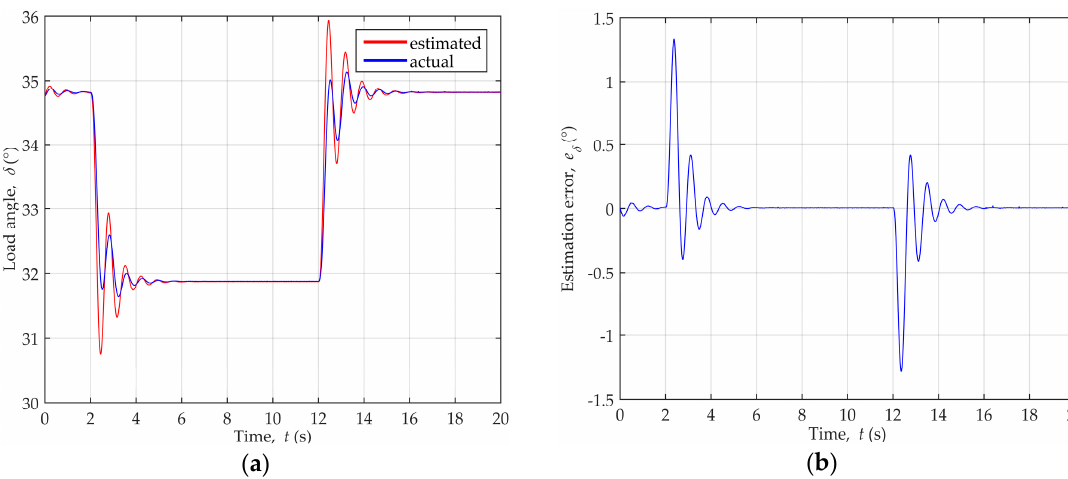
Figure 18. Generator power change during dynamic disturbances of active power for generator operating point P = 0.89, Q = 0.11 cap.: ( a ) Active power; ( b ) Reactive power.